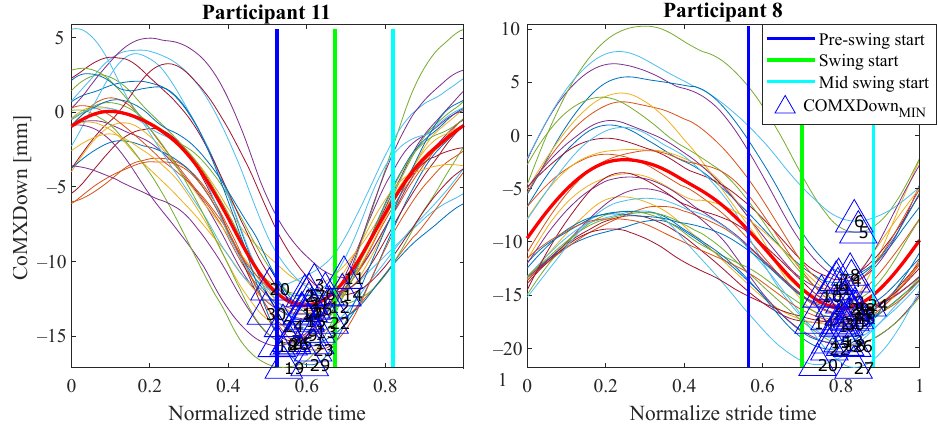
Figure 16. Evolution of the variable CoMXDown for the tests carried out by P8 and P11. A time shift can be observed in the variable when comparing the tests. As a result, the event formed by CoMXDown MIN anticipate a different phase for one volunteer and the other.